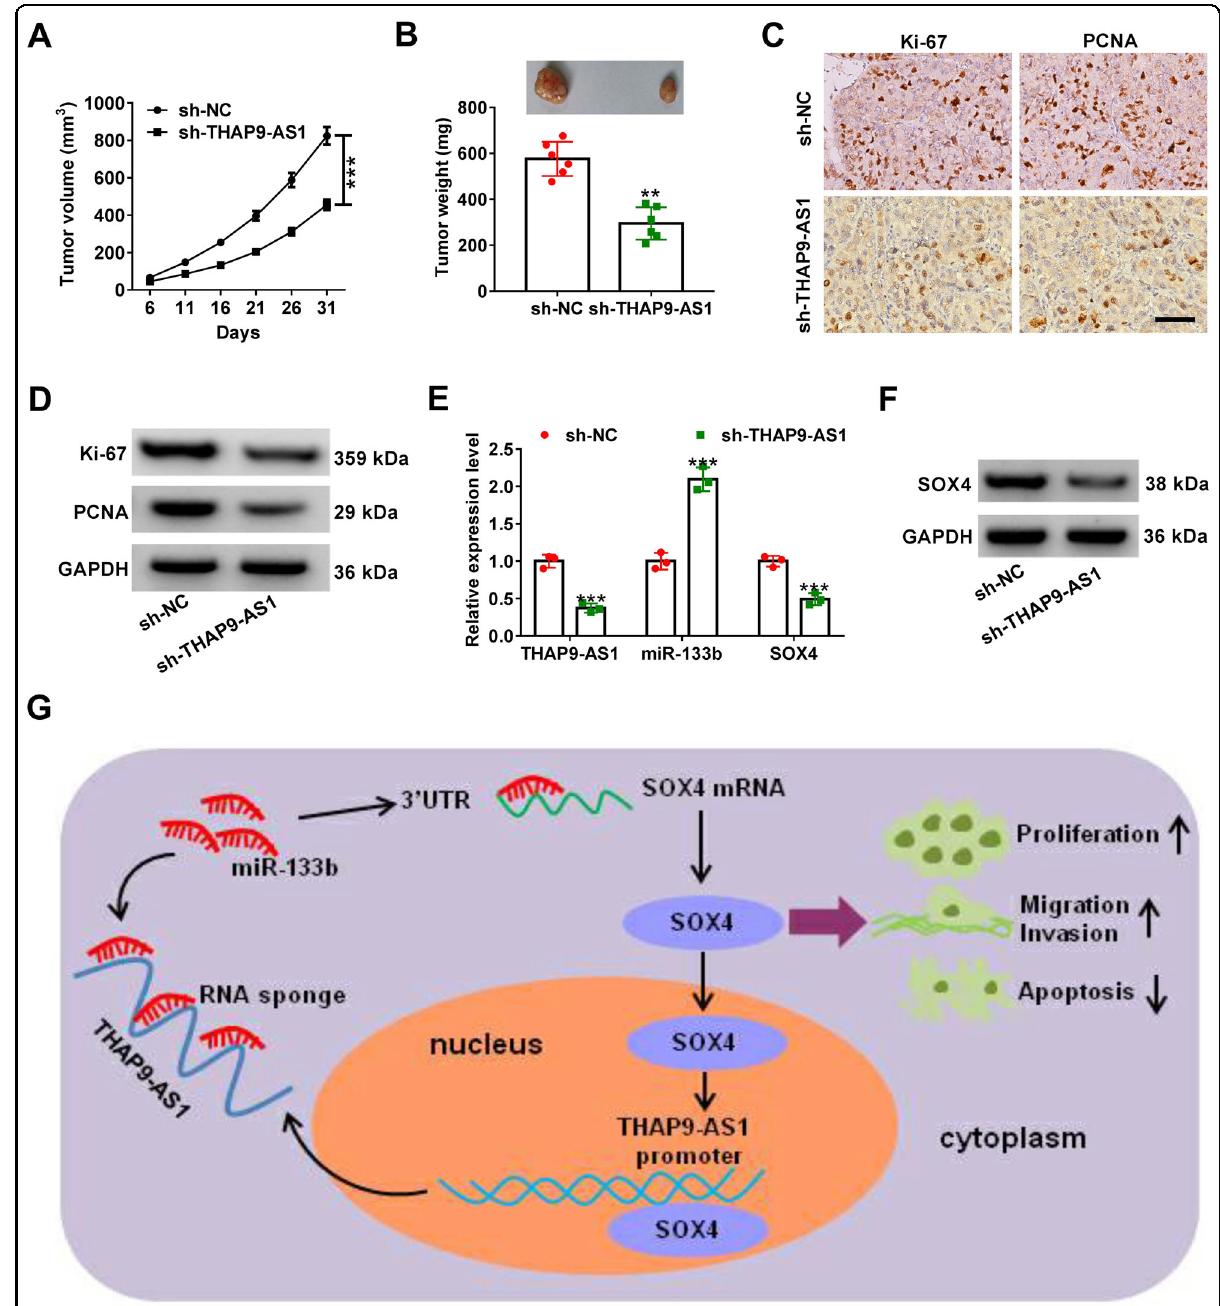
Fig. 8 THAP9-AS1 accelerates ESCC tumor growth in vivo. Eca-109 cells infected with lentivirus vectors carrying sh-THAP9-AS1 or negative control (sh-NC) were inoculated into nude mice. A Growth curve of xenografts from mice in sh-NC and sh-THAP9-AS1 group. B Quanti fi cation of tumor weight in mice at 31 days after injection. C and D IHC staining and western blot assay were used to determine the protein expression of Ki-67 and PCNA in excised tumors. E qRT-PCR assay was utilized to evaluate the expression of THAP9-AS1, miR-133b, and SOX4 mRNA in resected tumors. F Western blot assay of SOX4 protein level in xenografts from mice. G A schematic illustration shows that SOX4-induced THAP9-AS1 promotes cell proliferation, migration, and invasion by sponging miR-133b and upregulating SOX4, depicting a THAP9-AS1/miR-133b/SOX4 positive feedback loop that contributes to ESCC progression. *** P <